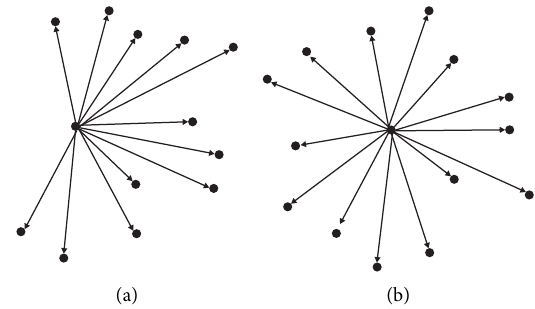
Figure 1: (a) Boundary point. (b) Not a boundary point.